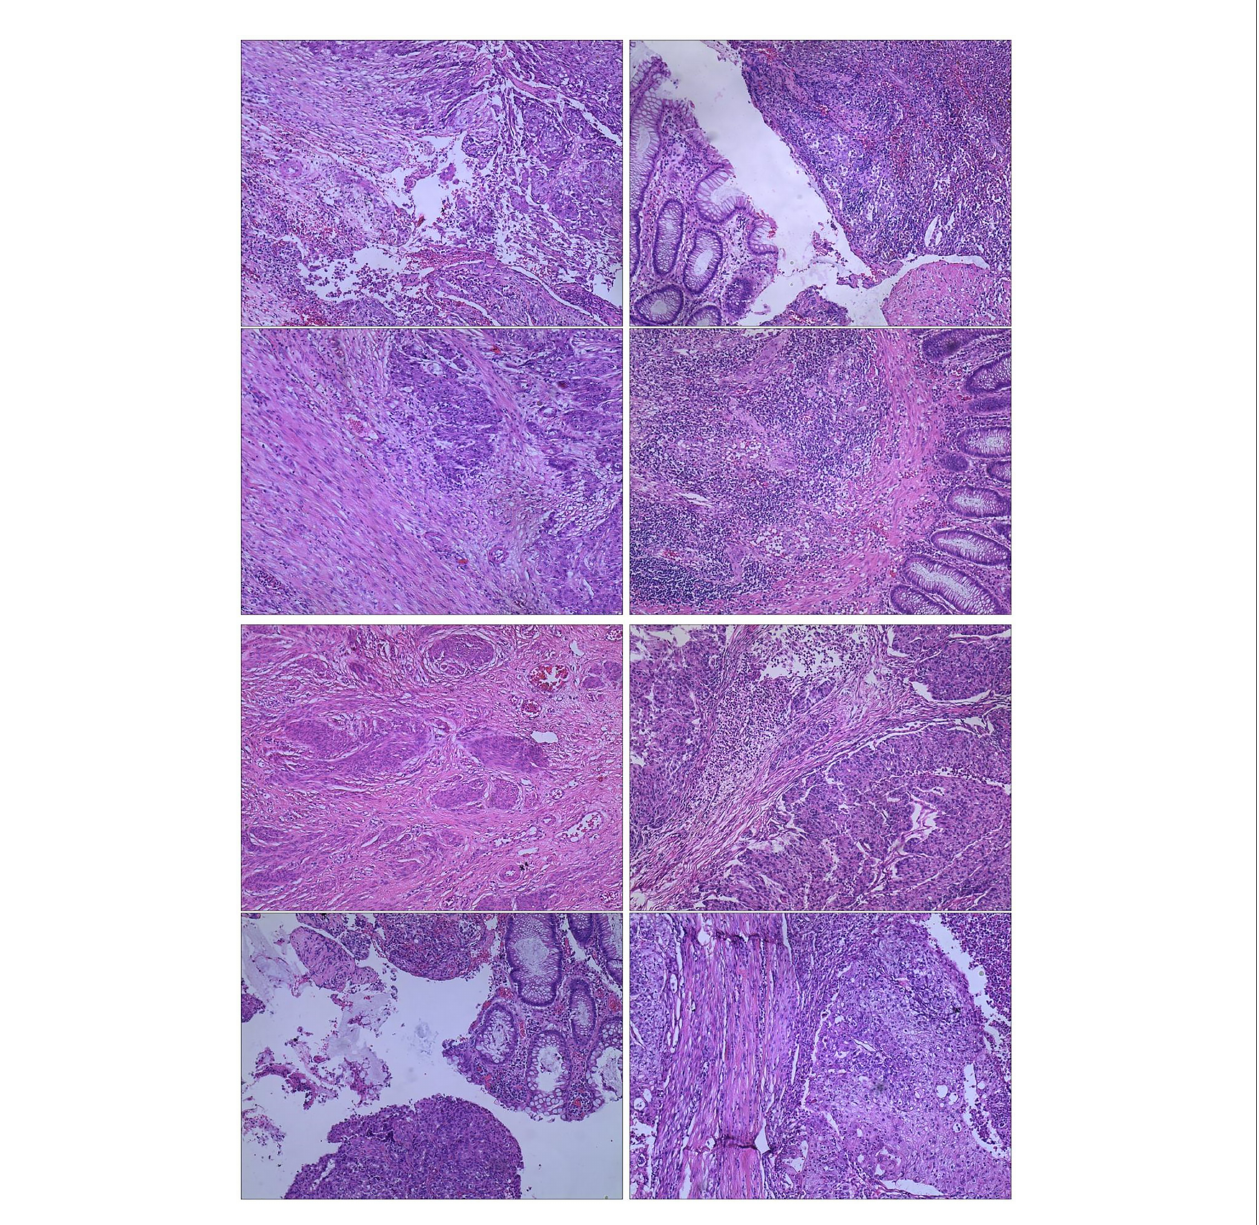
FIGURE 4 | Histopathology of primary